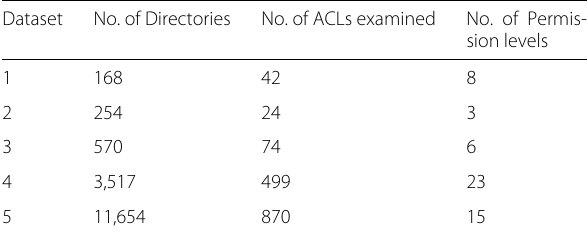
Table 6 Characteristics of the real-world file systems acquired for empirical analysis